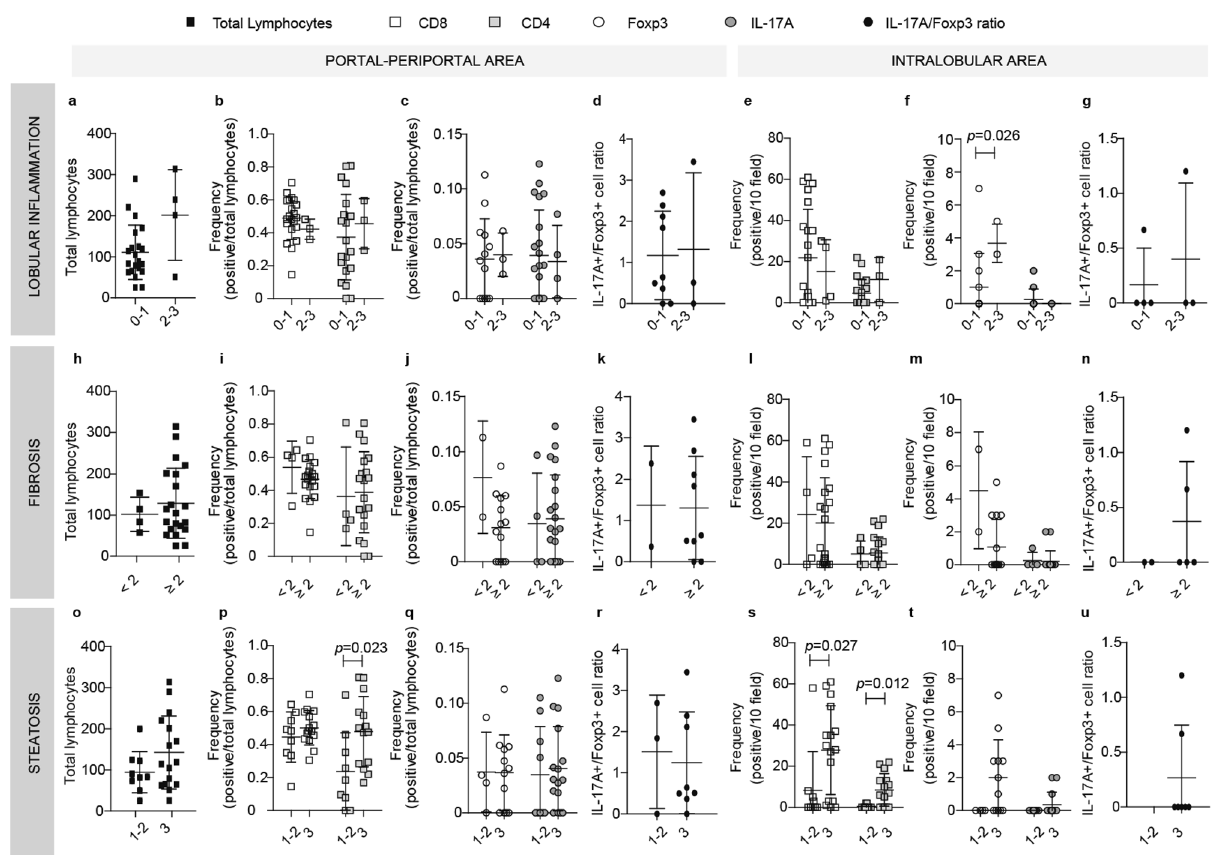
Figure 2. Relationship between intrahepatic infiltrate and liver damage in NAFLD pediatric cases. Lymphocyte quantification related to lobular inflammation ( a – g ), fibrosis ( h – n ) and steatosis ( o – u ) severity. Total lymphocytes ( a , h , o ), CD8+ and CD4+ ( b , i , p ), Foxp3+ and IL-17A+ cell frequency ( c , j , q ) and IL-17A+ / Foxp3+ cell ratio ( d , k , r ) in portal-periportal area. CD8+ and CD4+ ( e , l , s ), Foxp3+ and IL-17A+ cell frequency ( f , m , t ) and IL-17A+ /Foxp3+ cells ratio ( g , n , u ) in intralobular